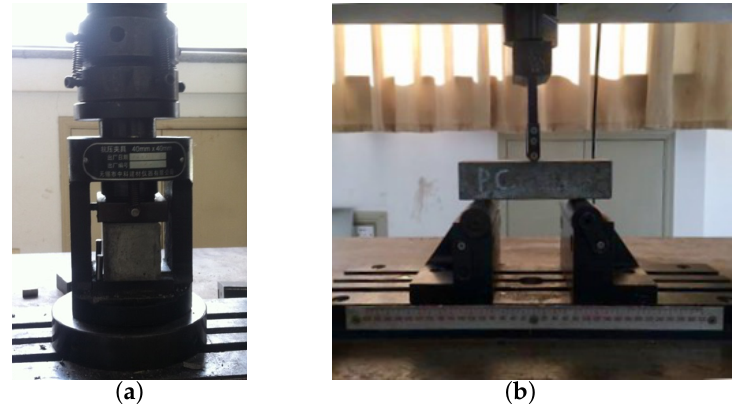
Figure 3. Experimental setup for static test. ( a ) Uniaxial compression test setup; ( b ) 3-point bending test